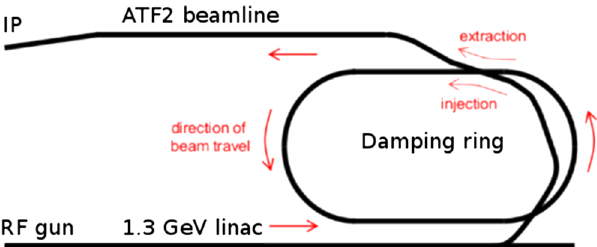
FIG. 1. Schematic of the ATF layout, with the ATF2 focal point indicated as the IP [8].